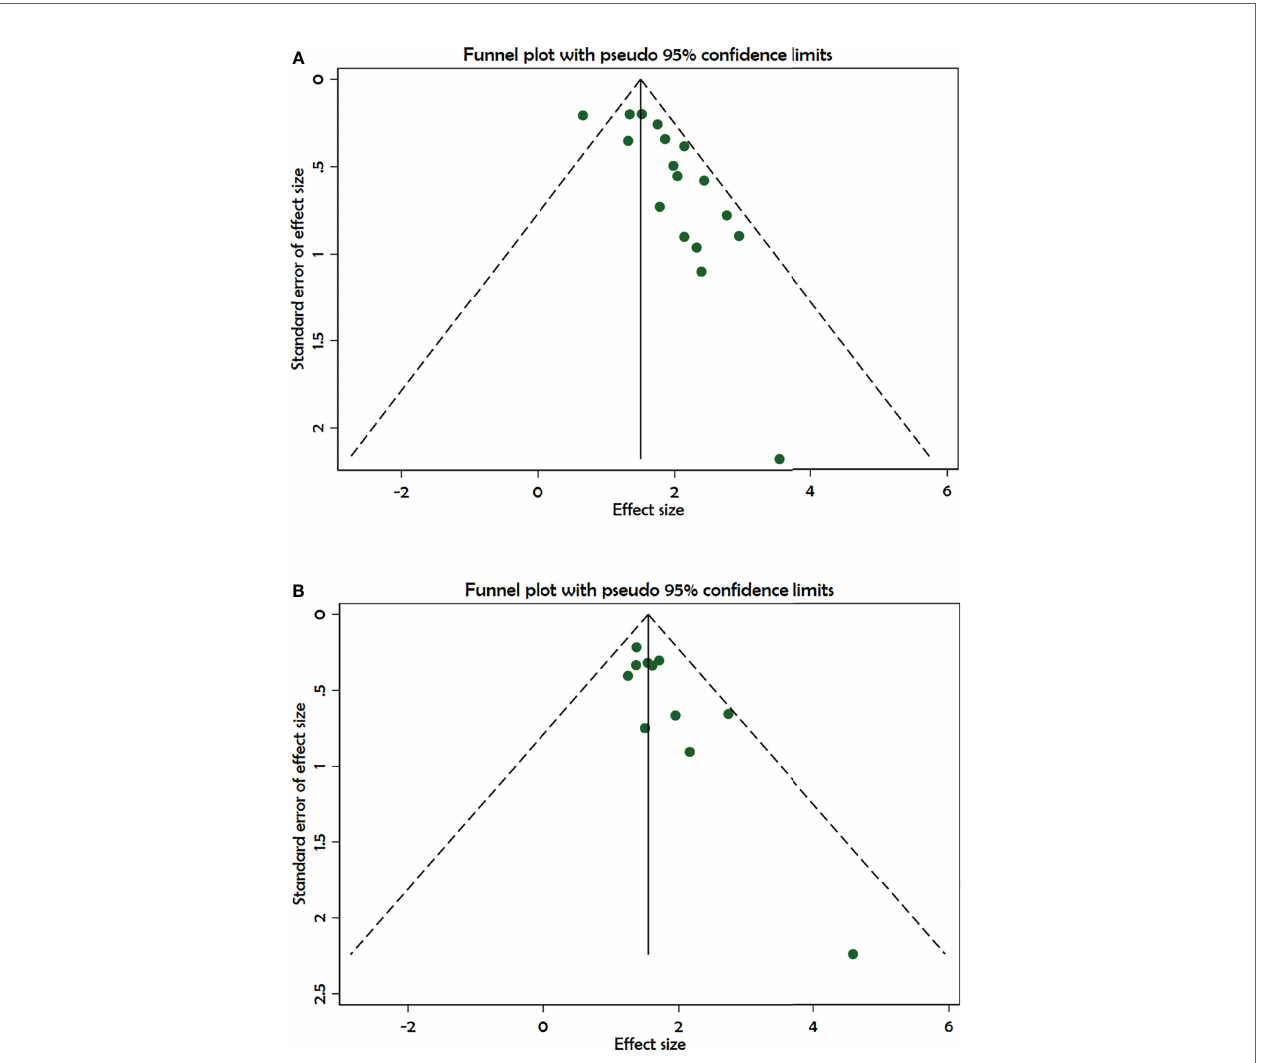
FIGURE 6 | Funnel plot showing publication bias. (A) Disease-free survival. (B) Overall